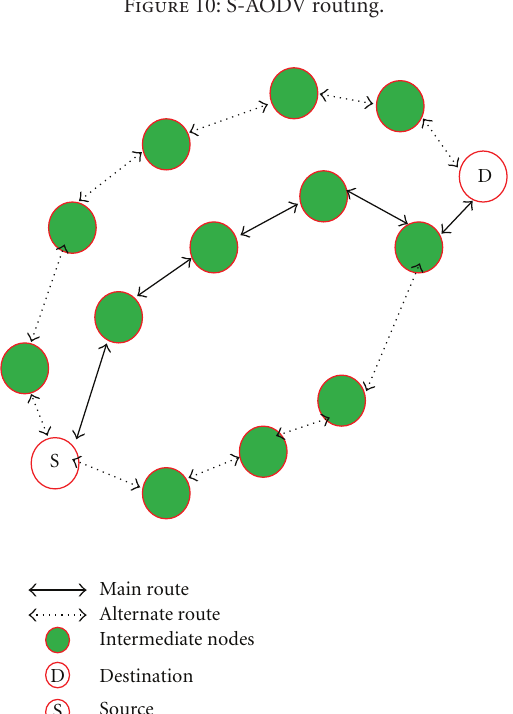
Figure 10: S-AODV routing.